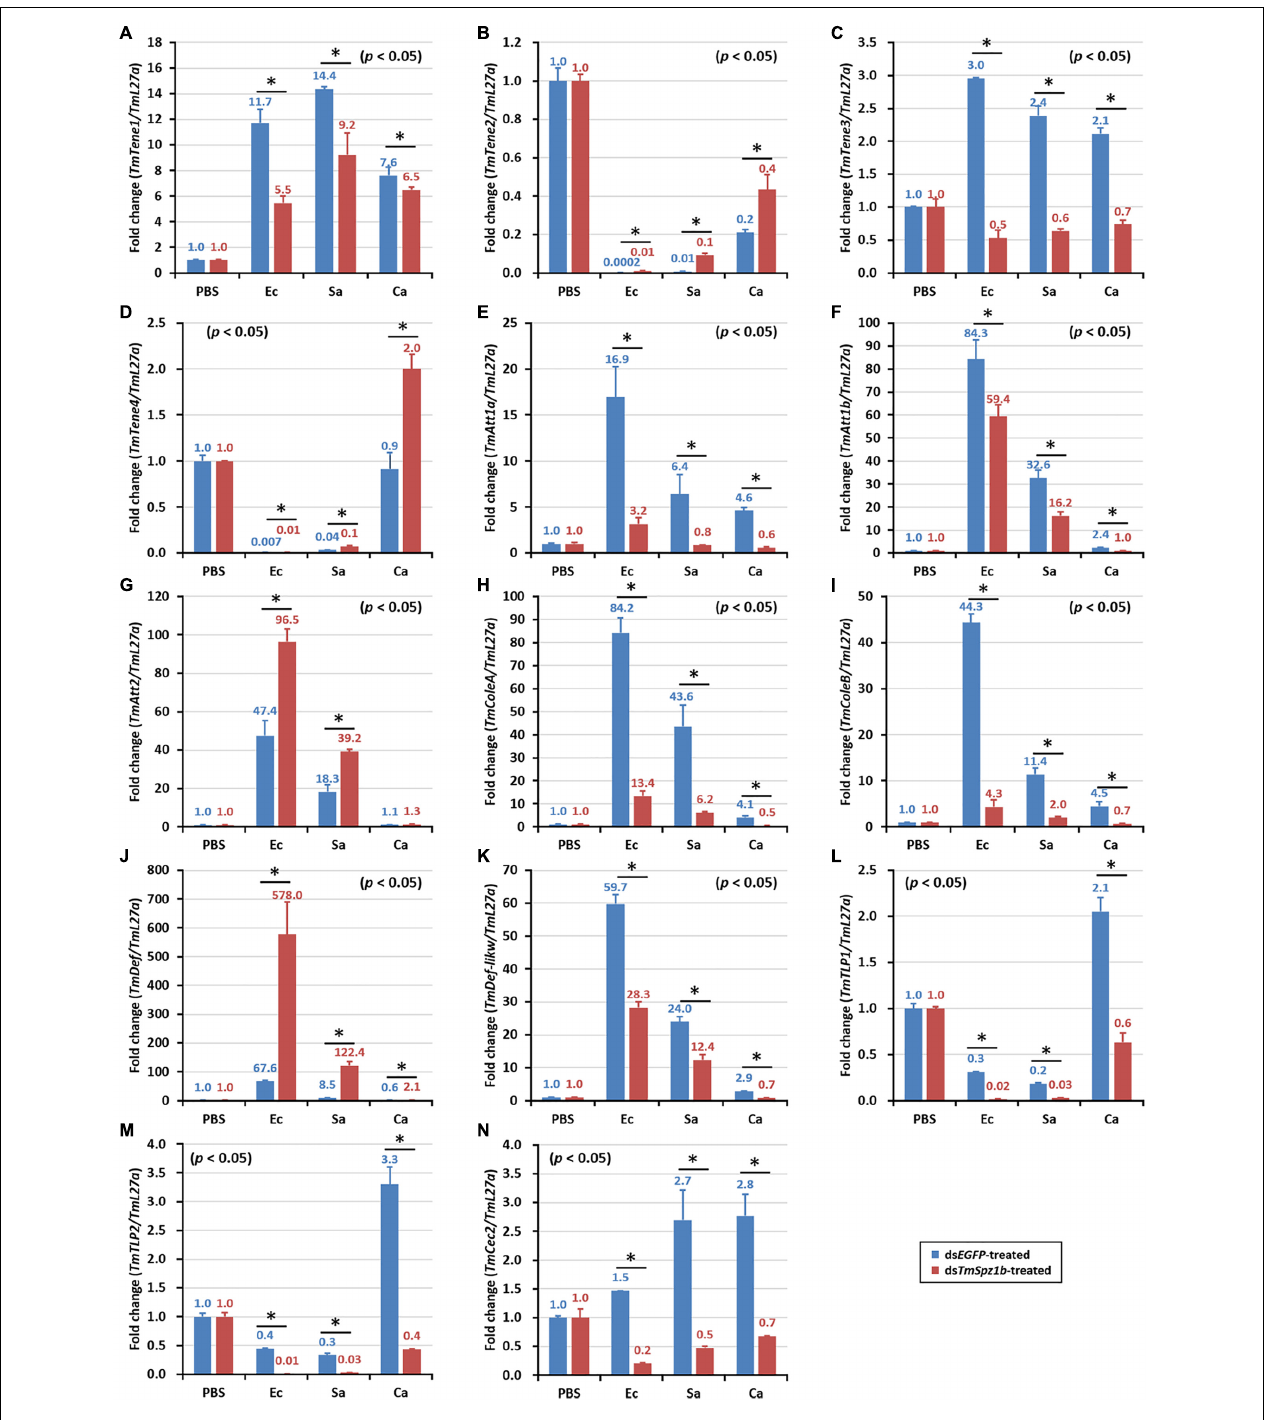
FIGURE 6 | Effects of TmSpz1b gene-silencing on the expression of 14 AMP genes in response to pathogen injection in hemocytes. E. coli, S. aureus, and C. albicans were injected into ds TmSpz1b -treated T. molitor larvae. The expression levels of 14 AMP genes were determined at 24 h post injection, by qRT-PCR. In hemocytes, seven AMP genes ( TmTenecin1 and 3 , TmAttacin1a , and 1b , TmColeoptericin1 and 2, and TmDefensin2 ) were significantly decreased by TmSpz1b RNAi. dsEGFP was injected as a negative control, and TmL27a was used as an internal control. All experiments were performed in triplicate. Asterisks indicate significant differences between ds TmSpz1b and ds EGFP -treated groups when compared by Student’s t -test ( P < 0.05). TmTene1 ( A ; TmTeneecin-1 ), TmTene2 ( B ; TmTenecin-2 ). TmTene3 ( C ; TmTenecin-3 ), TmTene4 ( D ; TmTenecin-4 ), TmAtt1a ( E ; TmAttacin-1a ), TmAtt1b ( F ; TmAttacin-1b ), TmAtt2 ( G ; TmAttacin-2 ), TmCole1 ( H ; TmColeoptericin-1 ), TmCole2 ( I ; TmColeoptericin-2 ), TmDef1 ( J ; TmDefensin-1 ), TmDef2 ( K ; TmDefensin-2 ), TmTLP1 ( L ; TmThaumatin-like protein-1 ), TmTLP2 ( M ; TmThaumatin-like protein-2 ), TmCec2 ( N ; TmCecropin-2 ).